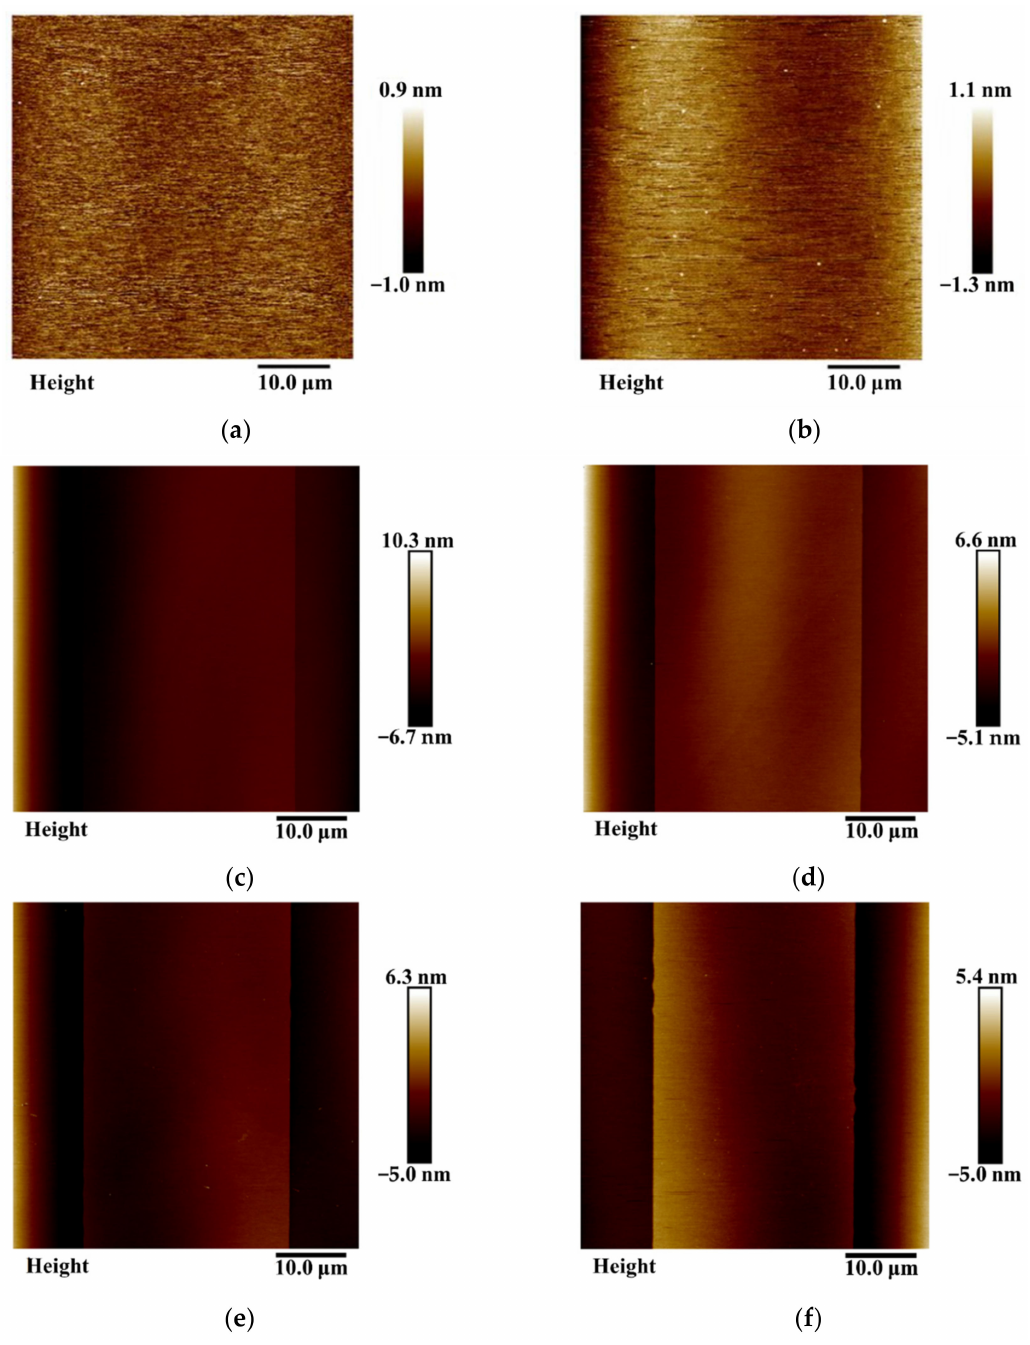
Figure 3. AFM scanning results for surface morphology. ( a ) The surface morphology of monocrys- talline silicon measured using AFM. The surface roughness value is R a = 0.161 nm. ( b ) The surface morphology of Al 2 O 3 film fabricated using ALD. The surface roughness value is R a = 0.165 nm. ( c ) The surface morphology of the nano-step with a height of 1 nm. ( d ) The surface morphology